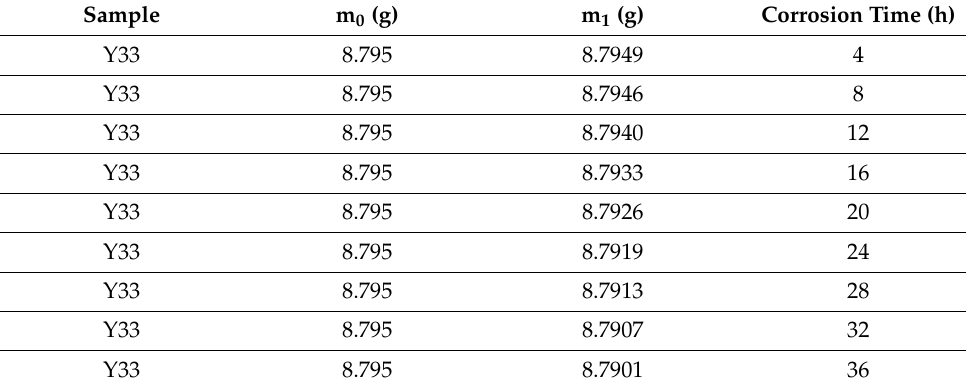
Figure 5. ( a ) Surface element distribution of the sample, ( b ) SEM image of the cemented carbide after etching, ( c ) micro ‐ metallographic image of the cemented carbide sample. Table 5. Sample mass before and after